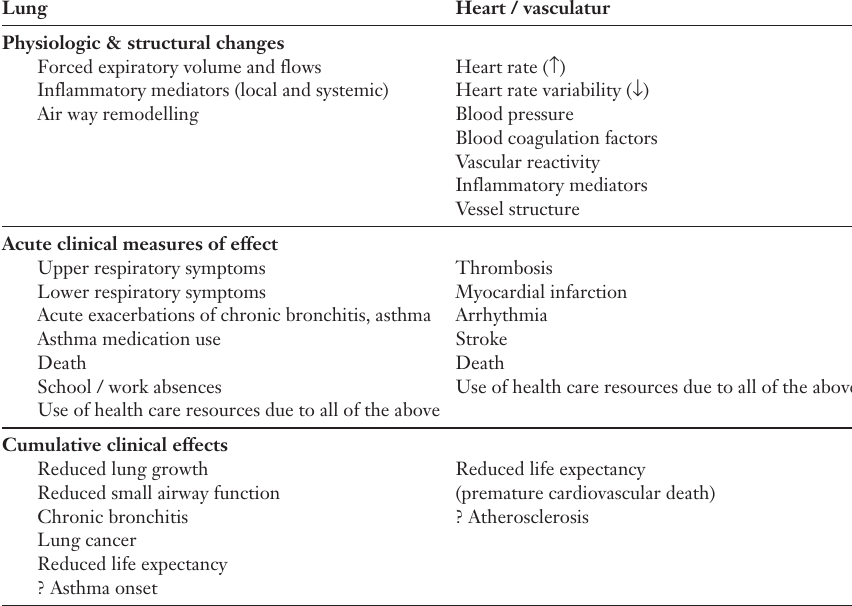
Table 1 List of respiratory and cardiovascular physiologic, struc- tural, and clinical outcomes reported to be associated with exposure to ambient air pollution (? means evidence is